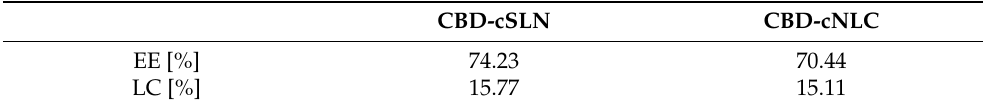
Table 3. Encapsulation efficiency (EE%) and loading capacity (LC%) for CBD-cSLN, CBD-cNLC.